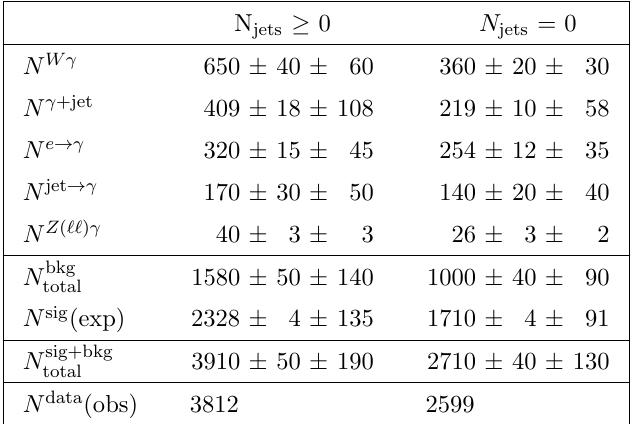
Table 3 . Summary of observed and expected yields (all backgrounds and signal) for events passing the selection requirements in data for the inclusive ( N jets 0) and exclusive ( N jets = 0) selections. (cid:21) The W(cid:13) and (cid:13) +jet backgrounds are scaled by the normalization factor from the (cid:12)t, luminosity and cross section. The e (cid:13) and jet (cid:13) backgrounds are estimated using data-driven techniques. The ! ! row labelled \ N sig (exp)" corresponds to the Sherpa NLO prediction. The row labelled \ N sig+bkg " total corresponds to the sum of the expected background contributions and expected signal. The (cid:12)rst uncertainty is statistical, while the second is